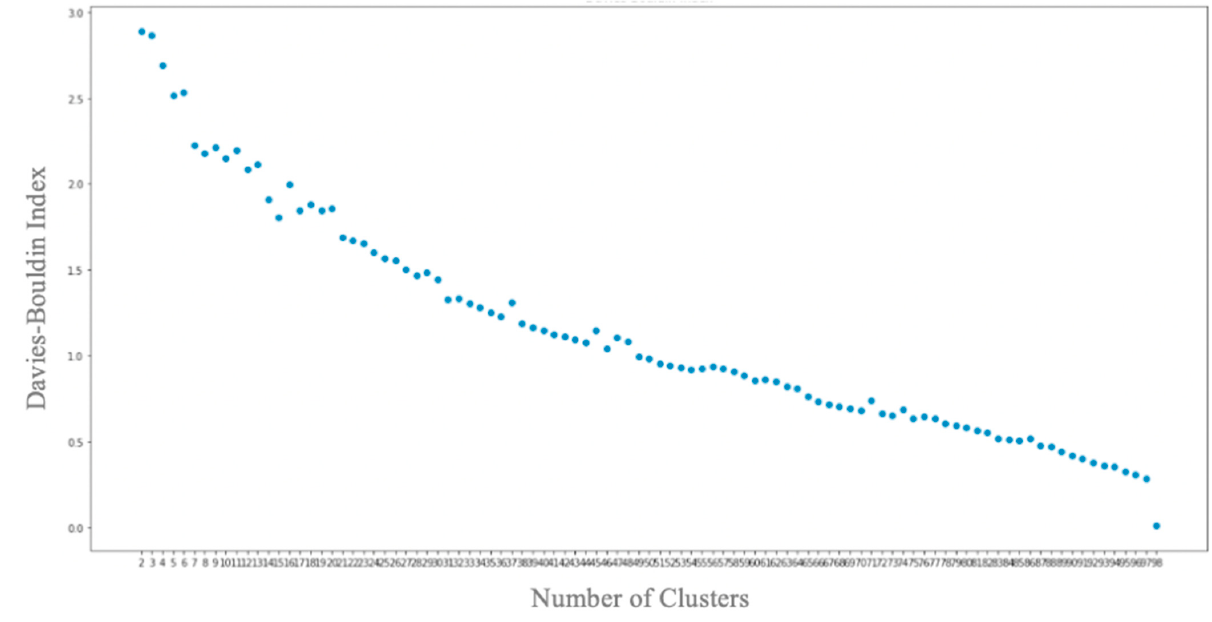
Figure 13. Davies–Bouldin index.